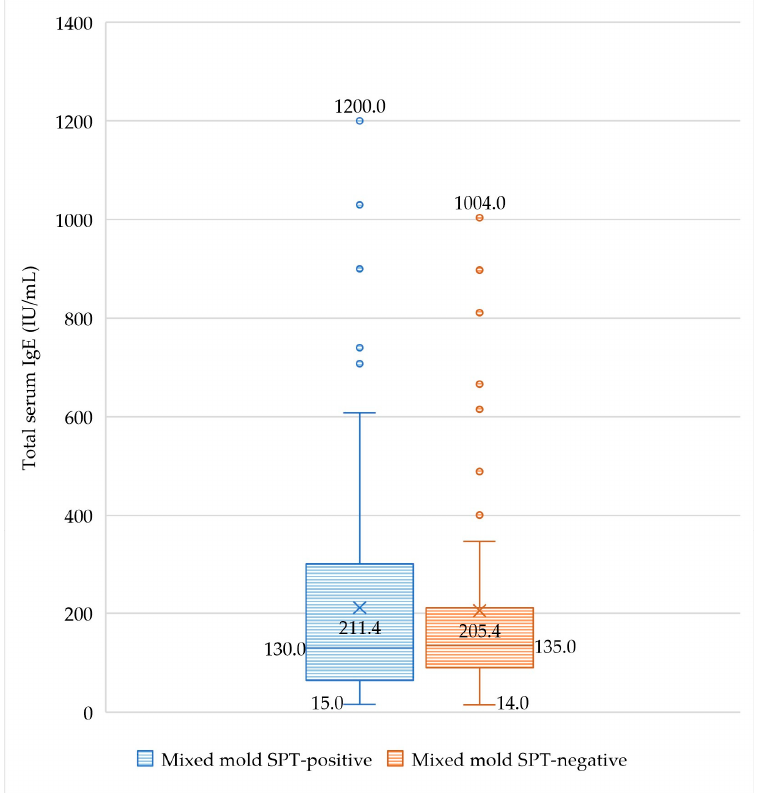
Figure 6. Total IgE serum level (median and range) difference between mixed mold skin prick test (SPT) ‐ positive and negative patients. Data were analyzed by Mann–Whitney U test (N = 200). ×, mean.